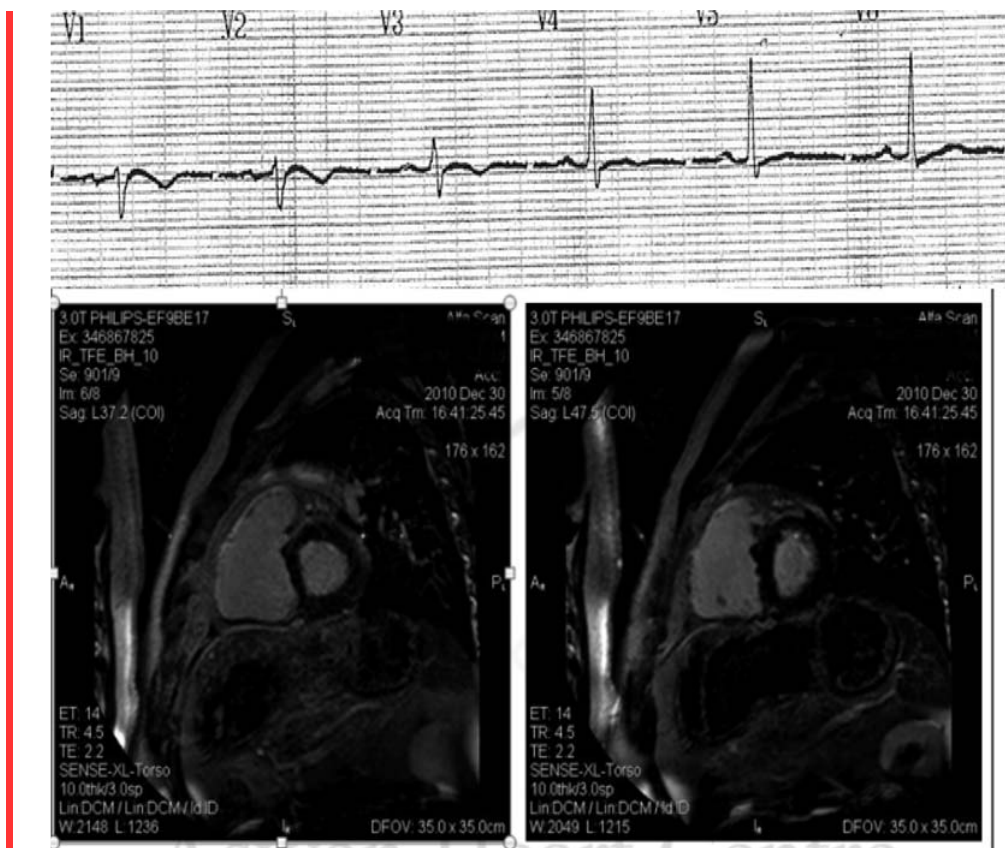
Figure 6. Above: Surface ECG precordial lead recordings of a 50 year old Egyptian/Sudanese patient showing Epsilon wave in V1, T wave inversion in V1-3, and relative QRS prolongation in right precordial leads. Below: Cardiac magnetic resonance imaging demonstrating delayed gadolinium enhancement in the right ventricular free wall denoting extensive fibrosis. The patient suffered two episodes of sustained ventricular tachycardias with left bundle branch block pattern with altered level of consciousness. An ICD was implanted for secondary prevention. (Images courtesy of Mohamed Donya, MD, FRCR, Aswan Heart Centre, Aswan,